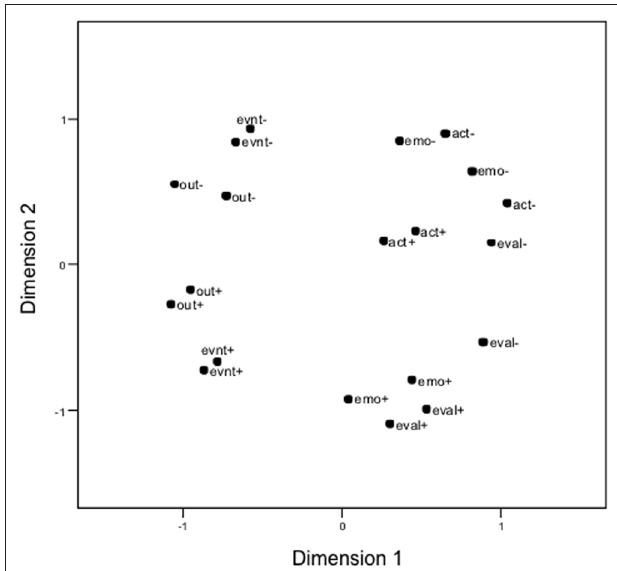
FIGURE 2 | Multidimensional scaling solution of behaviors based on similarity sortings, Experiment 1. act, action; emo, emotion; eval, evaluation; out, outcome; evnt, event; + , positive behavior; − , negative